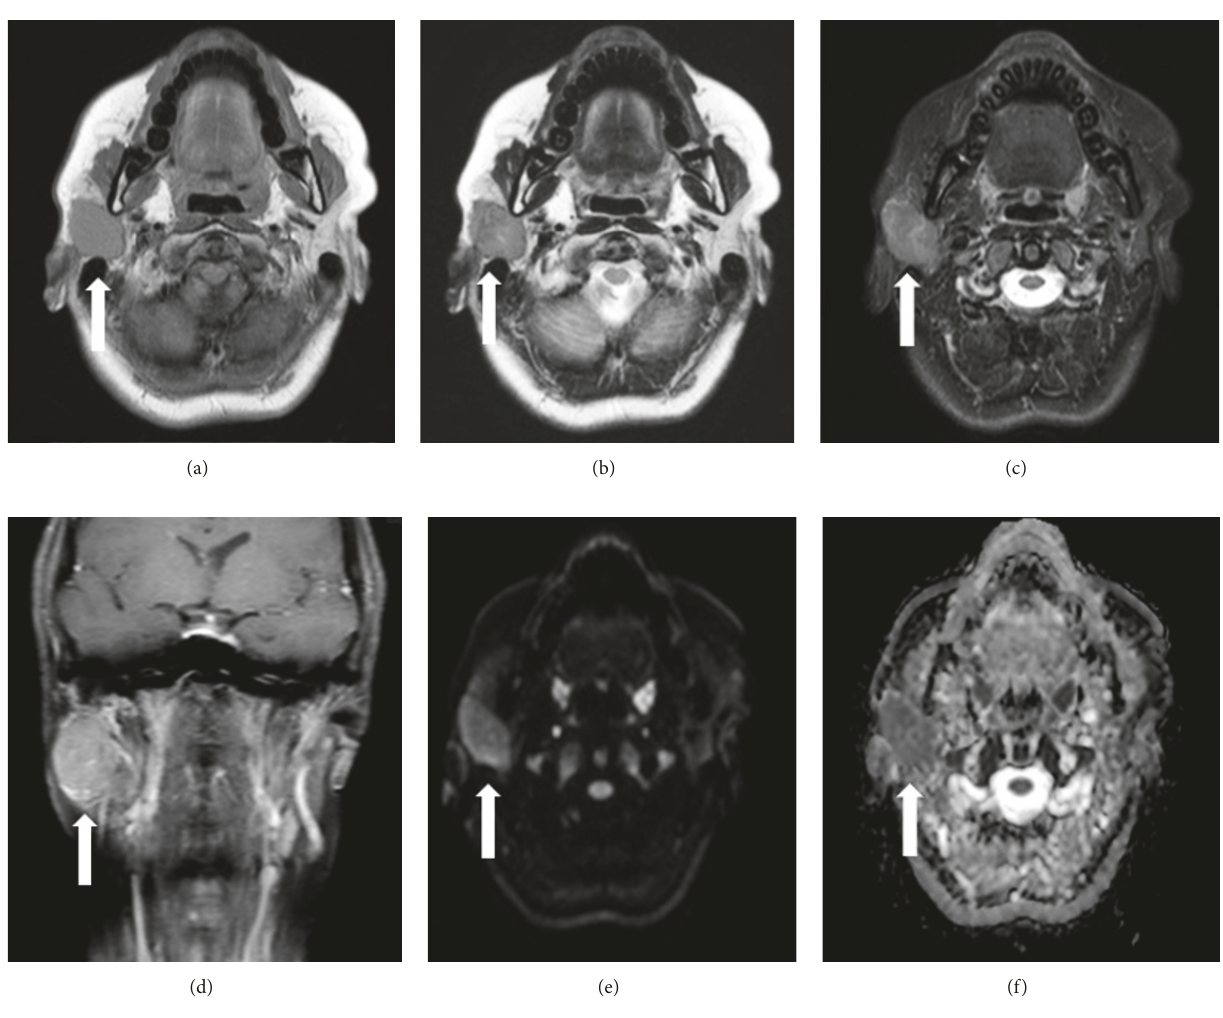
Figure 1: Magnetic resonance images of parotid oncocytoma. (a) T1-weighted imaging. (b) T2-weighted imaging. An axial magnetic resonance image shows a well-demarcated mass (white arrow) in the superficial and deep lobe of the right parotid gland. (c, d) The mass appears hyperintense to the native parotid gland tissue on fat-saturated T2-weighted imaging but hypointense on contrast-enhanced, fat- saturated T1-weighted imaging. (e, f) On diffusion-weighted images, the mass appeared hyperintense and hypointense according to the apparent diffusion